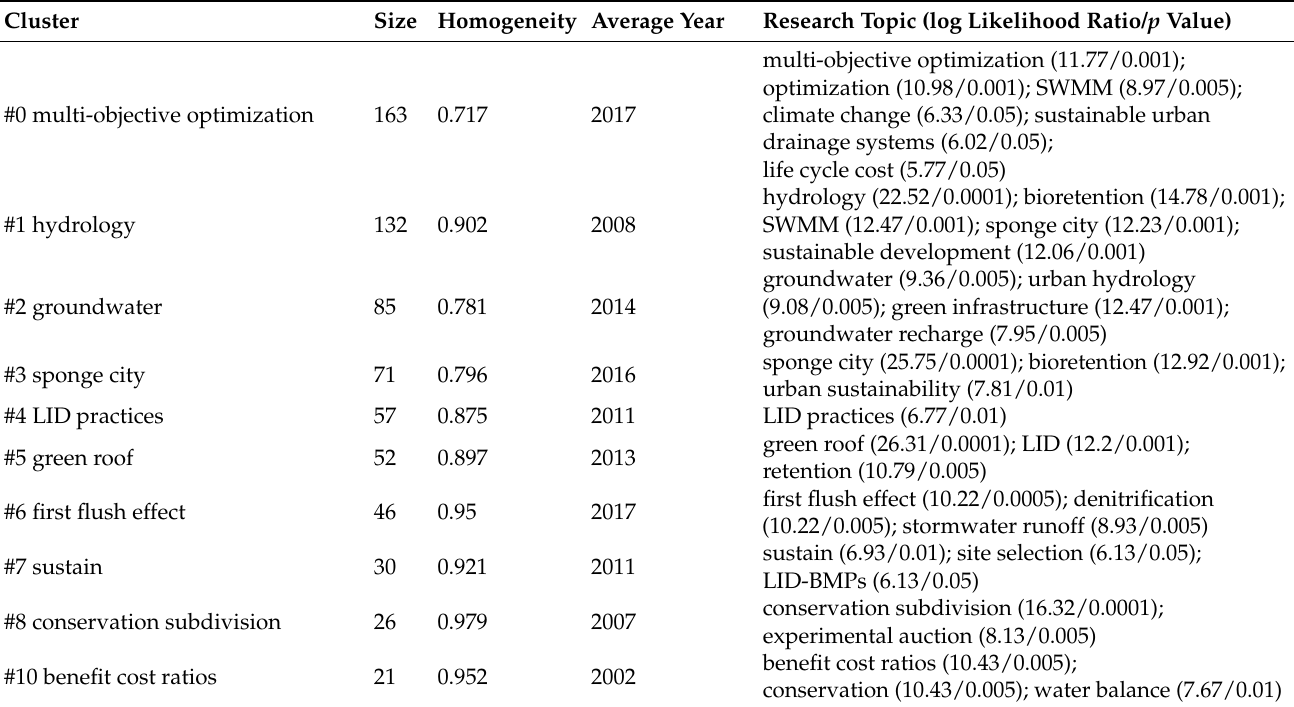
Figure 2. The time-line view of the keywords clustering based on the WOS. Table 6. The co-citation clustering of the LID research according to the Table 5. The keyword clustering of the publications based on the WOS database.